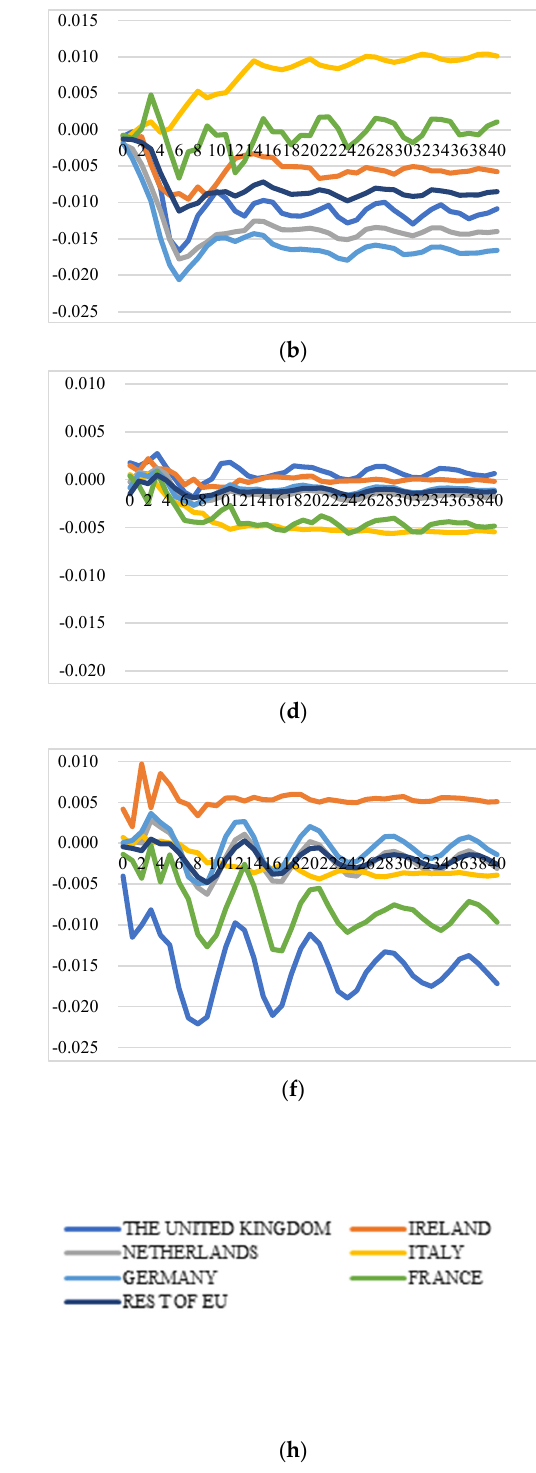
Figure 13. Generalized impulse response functions (GIRFs) of six EU member states’ intra-EU cheese export prices after a negative one-standard-error shock to cheese production (bootstrap median estimates). ( a ) GIRFs after a shock to France’s cheese production. ( b ) GIRFs after a shock to Germany’s cheese production. ( c ) GIRFs after a shock to Ireland’s cheese production. ( d ) GIRFs after a shock to Italy’s cheese production. ( e ) GIRFs after a shock to the Netherlands’ cheese production. ( f ) GIRFs after a shock to the UK’s cheese production. ( g ) GIRFs after a shock to the rest of the EU’s cheese production. ( h ) legend.